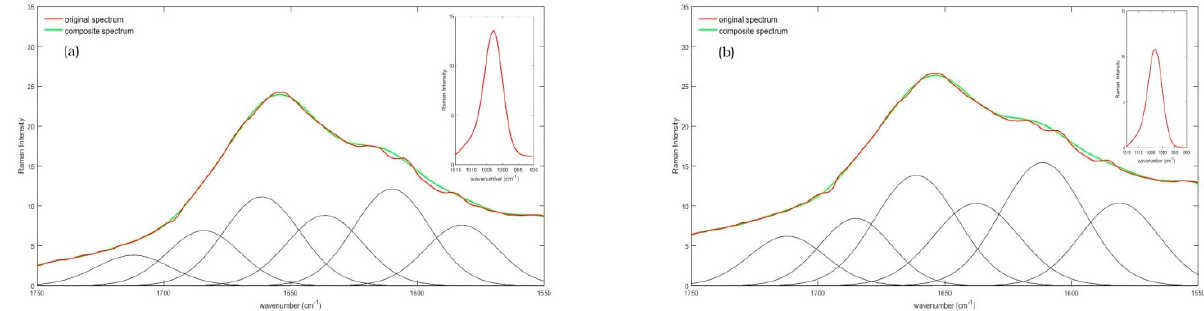
Figure 3. Average Raman spectrum, collected in the 1550–1750 cm − 1 spectral range of serum from ( a ) non-CD and; ( b ) CD subjects. In both spectra, the red line represents the original mean Raman spectrum, the black line identifies the Gaussian deconvoluted curves, and the green line shows the resulting composite spectrum, obtained from deconvolution computation. In the top right box of both figures the reference Phe peak is also displayed.